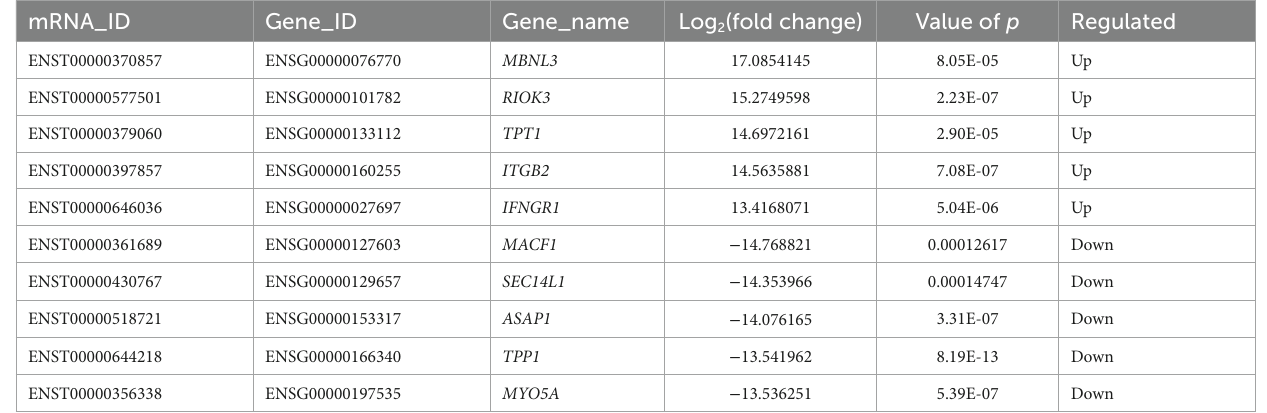
TABLE 4 The top 10 DE